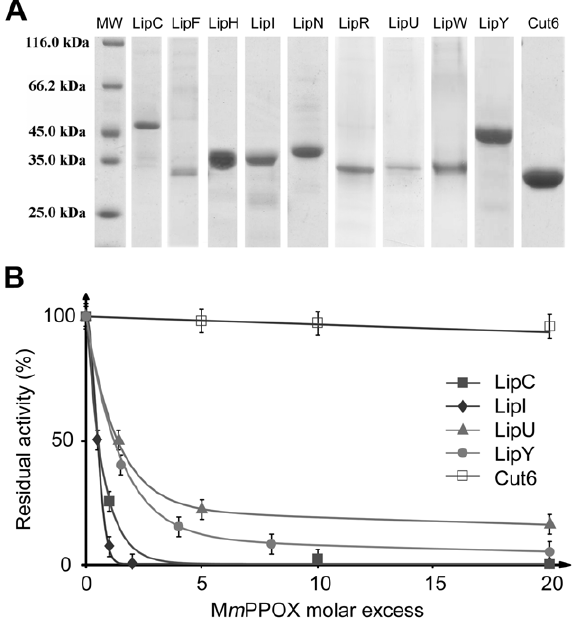
Figure 2. Inhibition of Lip-HSL proteins by M m PPOX. A , SDS- PAGE profile of the 9 Lip-HSL proteins used in this study, following purification using Ni 2 + -NTA resin. Quantity loaded: Molecular Weight (MW), 2 m g; LipC (46 kDa), 2 m g; LipF (31 kDa), 1 m g; LipH (36 kDa), 5 m g; LipI (36 kDa), 6 m g; LipN (42 kDa), 5 m g; LipR (34 kDa), 3 m g; LipU (33 kDa), 1 m g; LipW (34 kDa), 3 m g; LipY (47 kDa), 10 m g; Cut6 (31 kDa), 9 m g. B , Residual activities of LipC, LipI, LipU, LipY and Cut6 after 10 min incubation with M m PPOX at various molar excess ( x I ). Residual activities were measured spectrophotometrically using p NPC4 as substrate. x I50 values were defined as the inhibitor molar excess leading to 50% enzymes residual activities.